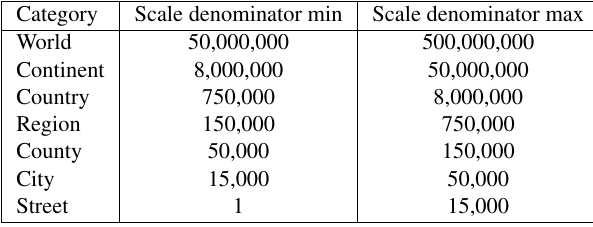
Table 1: The scale categories proposed, as an extension of the categories from (Touya and Reimer,